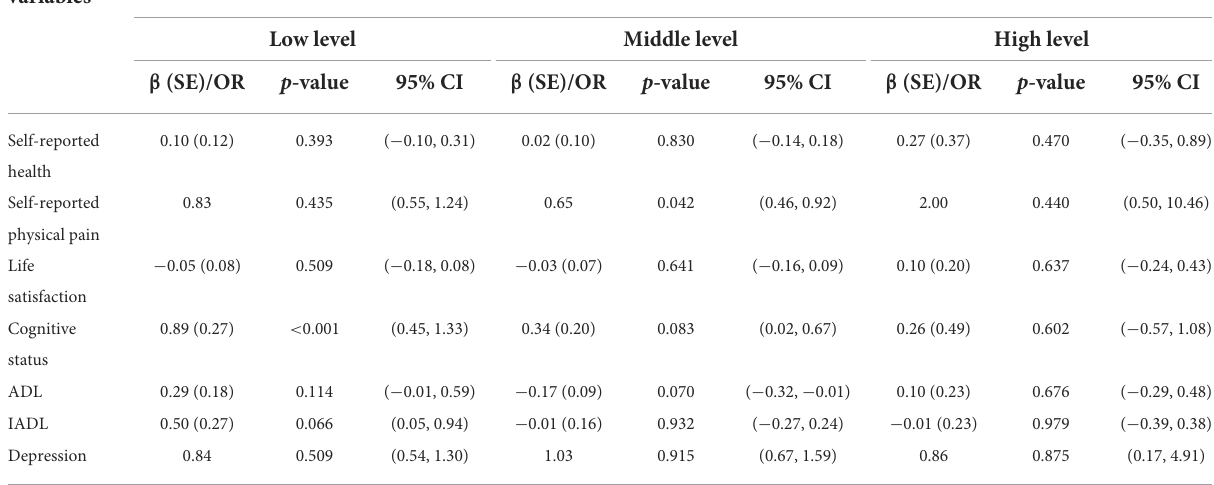
TABLE 4 Estimation of the intervention effect of retirement on the health of elderly men individuals of different education